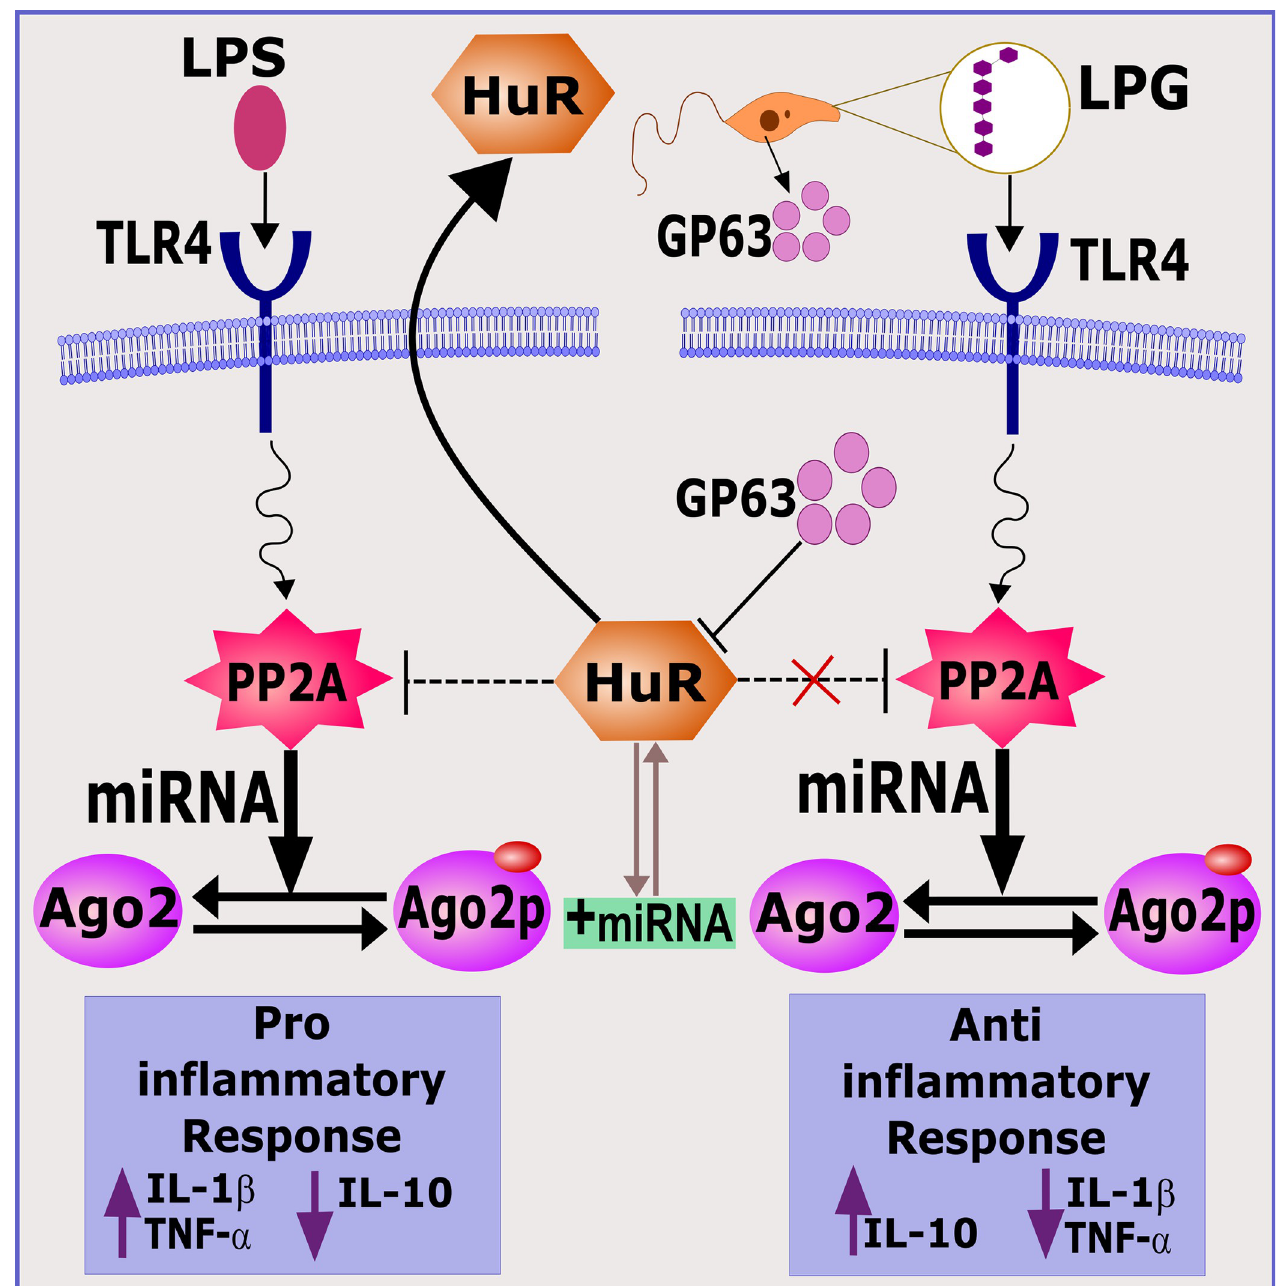
Fig 4. HuR and Phosphatases reciprocally regulate proinflammatory and anti-inflammatory cytokines. While Protein Phosphatase 2A (PP2A) increases miRNA activity, HuR overexpression down-regulates PP2A activation, and thereby miRNA expression, leading to increased proinflammatory cytokines. Leishmania -derived protease Gp-63 degrades HuR making active PP2A available for enhancing anti-inflammatory cytokines. On the other hand, Leishmania - derived LPG may activate TLRs to regulate PP2A activation that through regulation of argonaute proteins modulates cytokine response. LPG, lipophosphoglycan; miRNA,